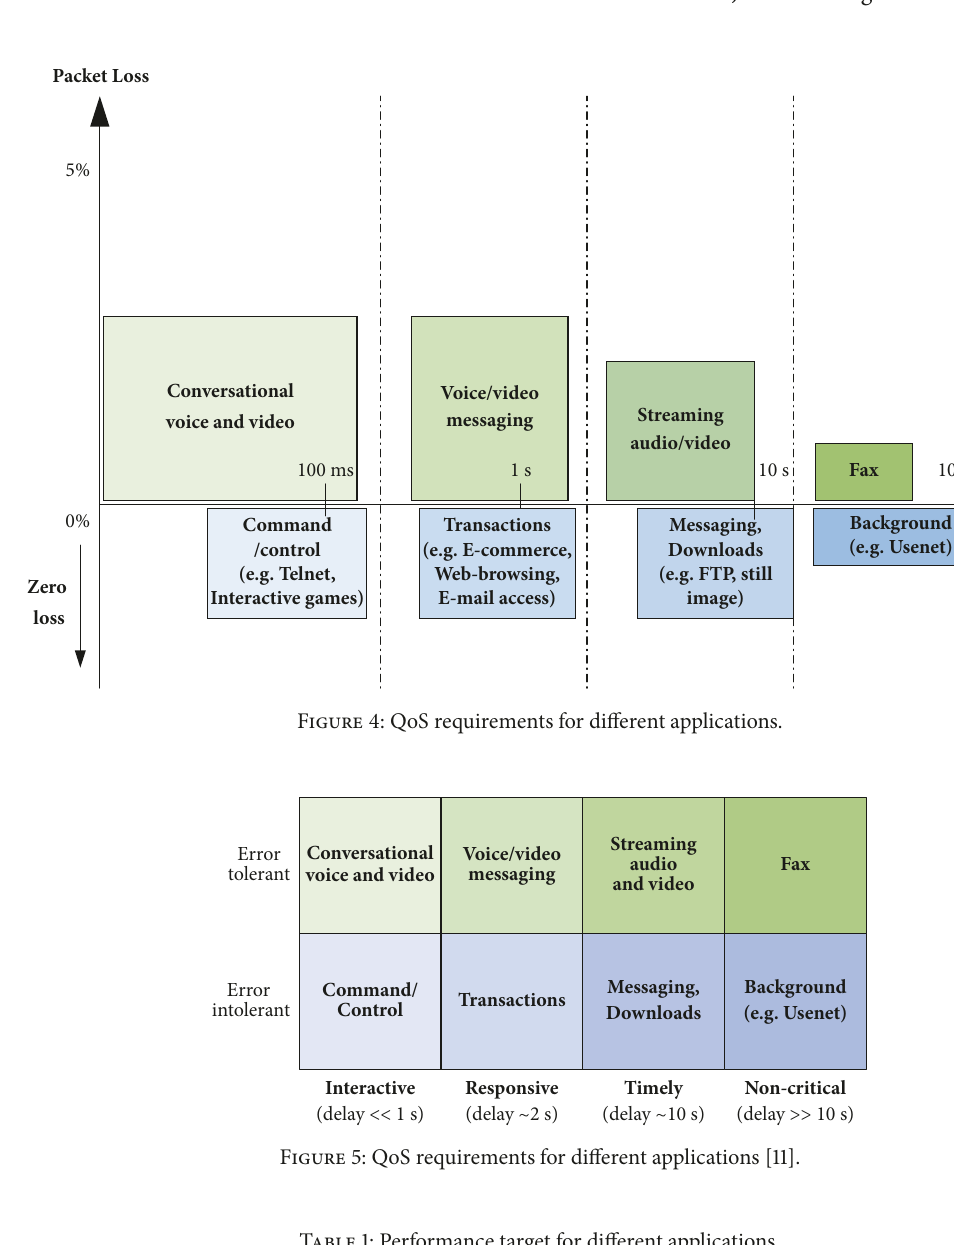
Table 1: Performance target for different